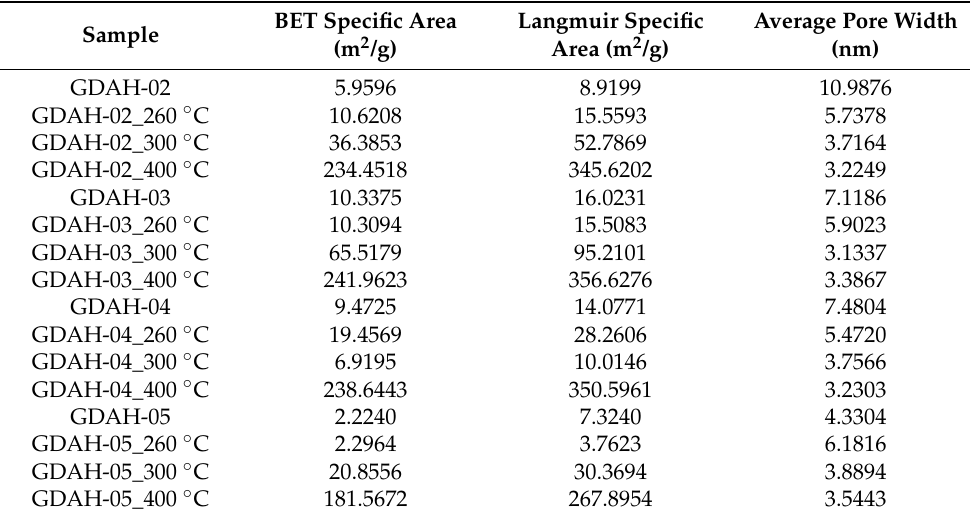
Table 3. Specific surface area and pore width measurements for the initial samples and samples after thermal treatments at 260, 300, or 400 ◦ C for 2 h.